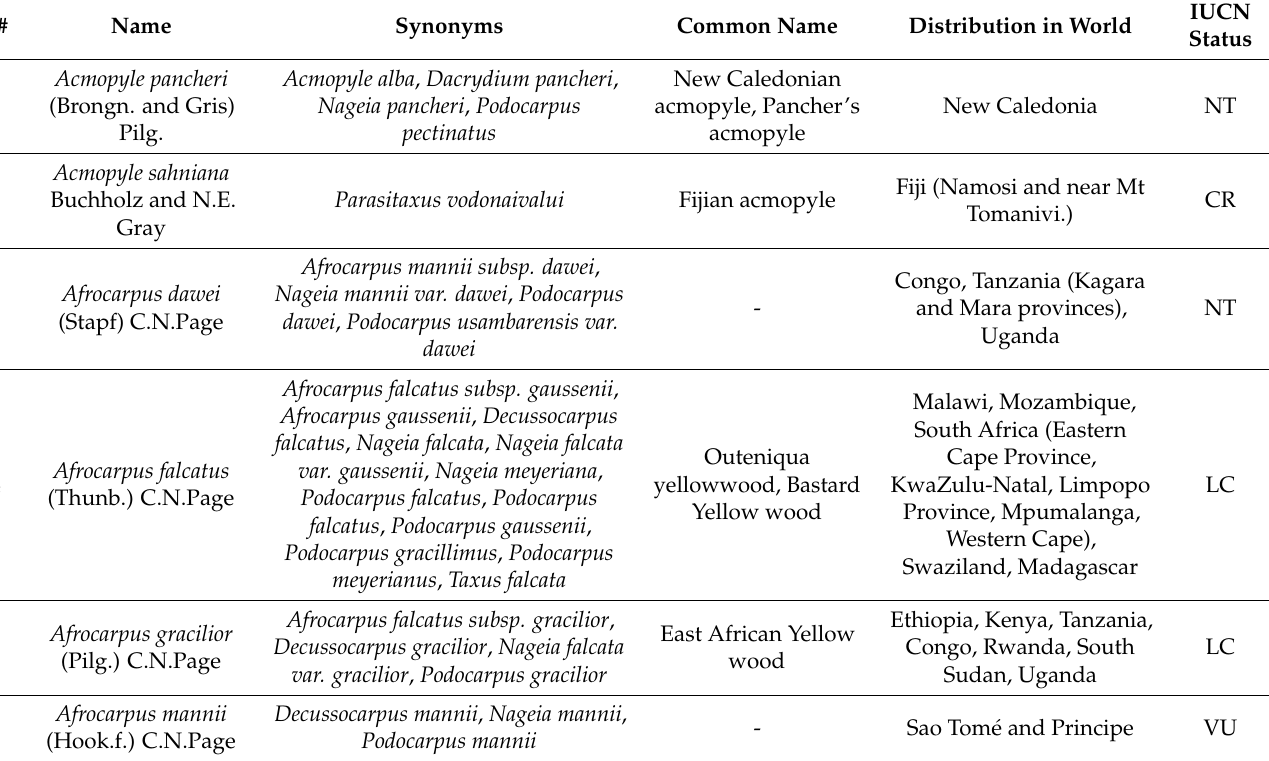
Table 1 and summarized here: Table 1. An updated checklist of living podocarp